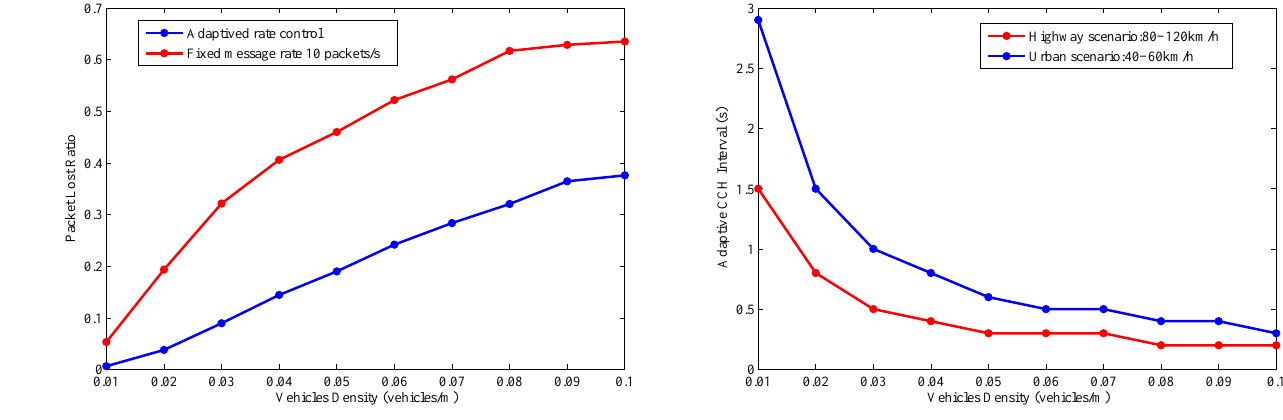
Figure 3. Packet loss rate versus vehicle’s density